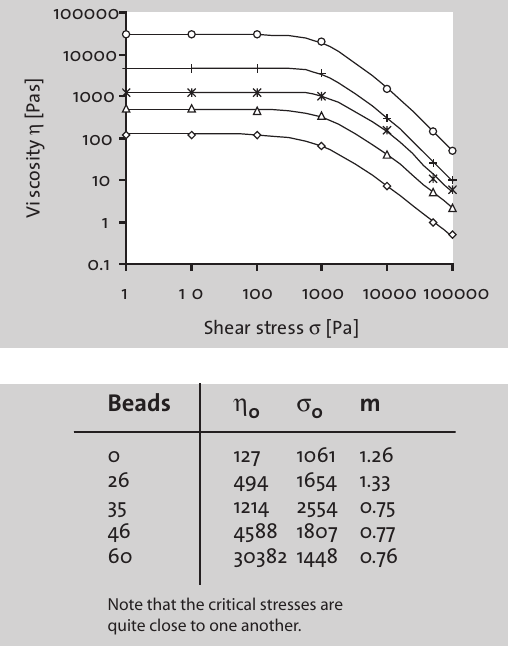
(cid:2) ‘Set target cell’ - point to cell containing sum